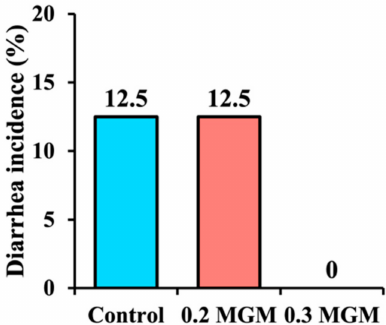
Figure 1. Effects of MGM-P supplementation on diarrhea incidence in weaned piglets.